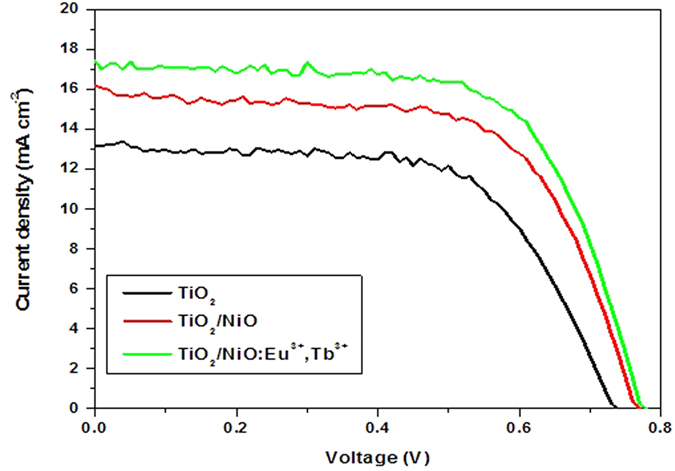
I-V curves of the DSSCs made from TiO2, TiO2/NiO and NiO:Eu3+,Tb3+ electrodes.